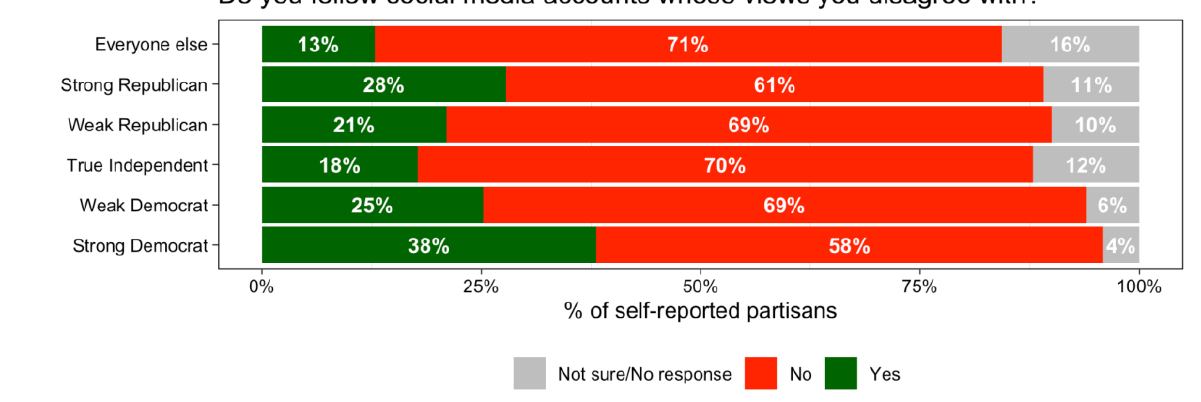
Figure 4. Non-congenial news consumption by party. This plot shows the baseline levels of following non-congenial news by different partisans. It shows that Democrats do so slightly more than Republicans (31% vs. 22%) and nearly twice as often as non-partisans or independents (17%). Overall, 27% of respondents answered that they follow social media accounts whose views they disagree with.